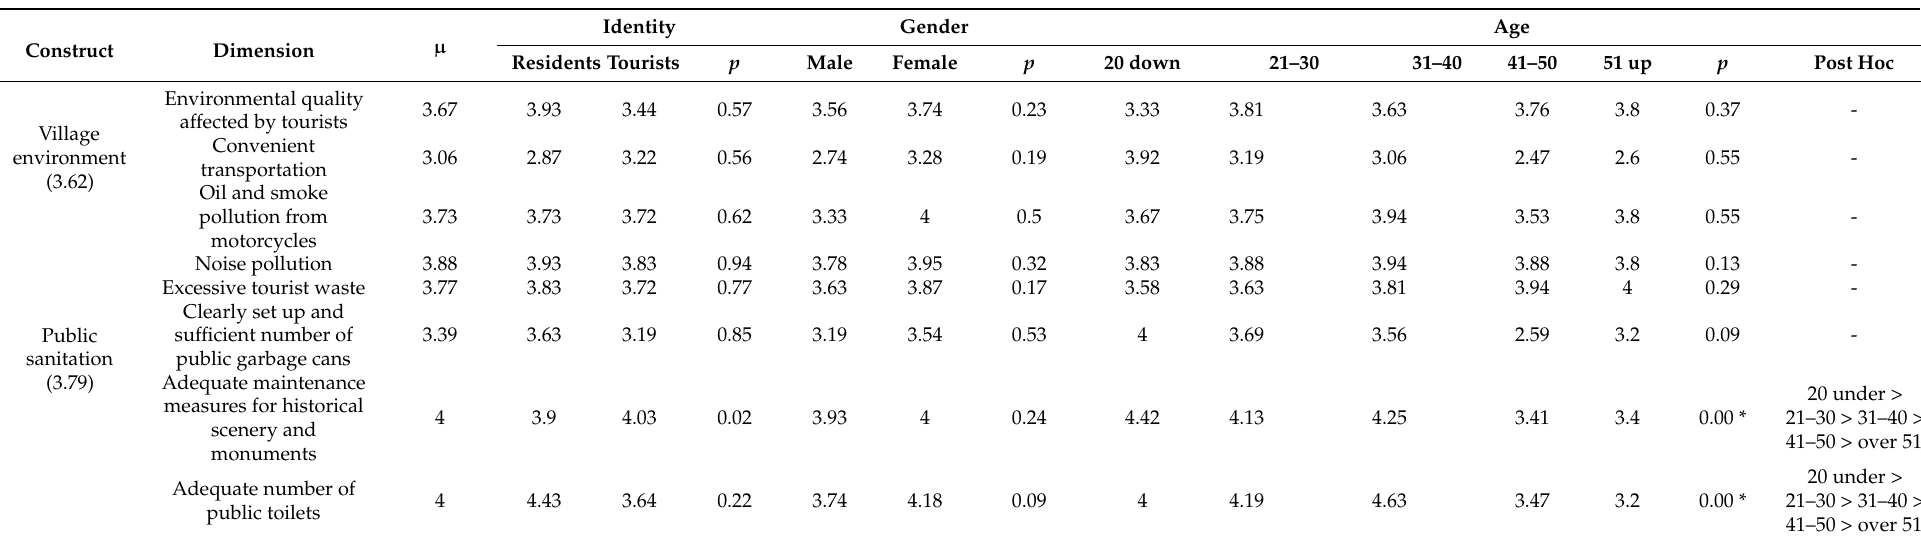
Table 6. Analysis of the awareness of the impact of religious and cultural tourism on the village